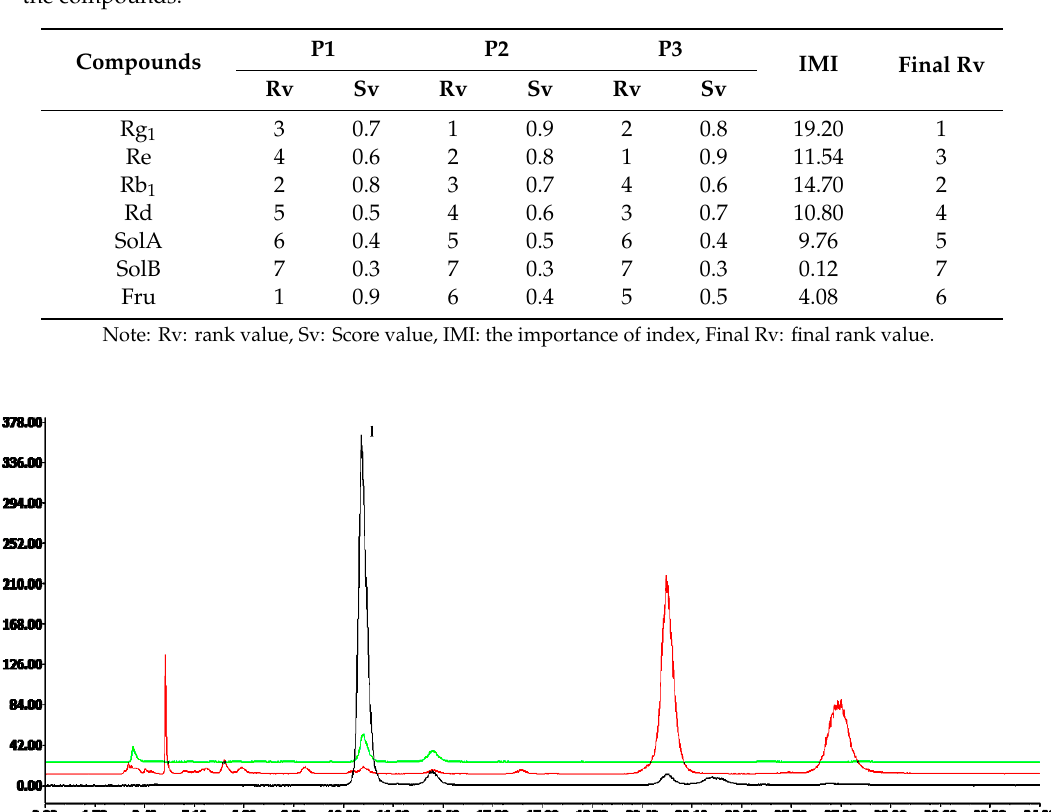
Figure 10. A comprehensive evaluation of the seven representative compounds based on the “Spider-web” mode. Table 3. The ranking value and score value of the three dimensions, the IMI, and ranking of the compounds.